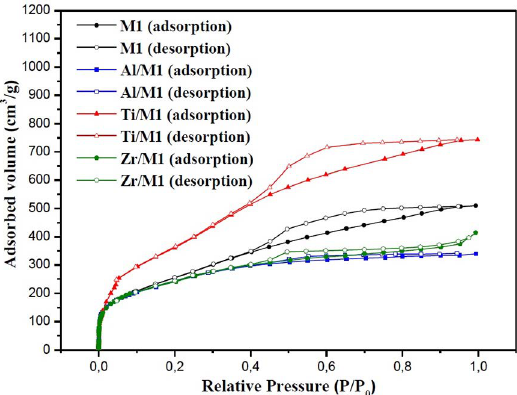
adsorption-desorption isotherms of the samples M1, Figure 4. N 2 Al/M1, Ti/M1 and Zr/M1.